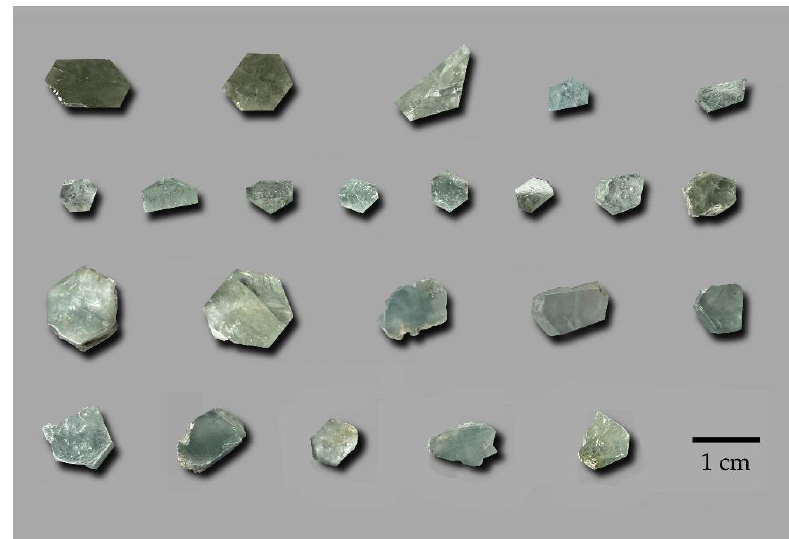
Figure 2. Top view photo of 23 samples, hexagonal short columns.